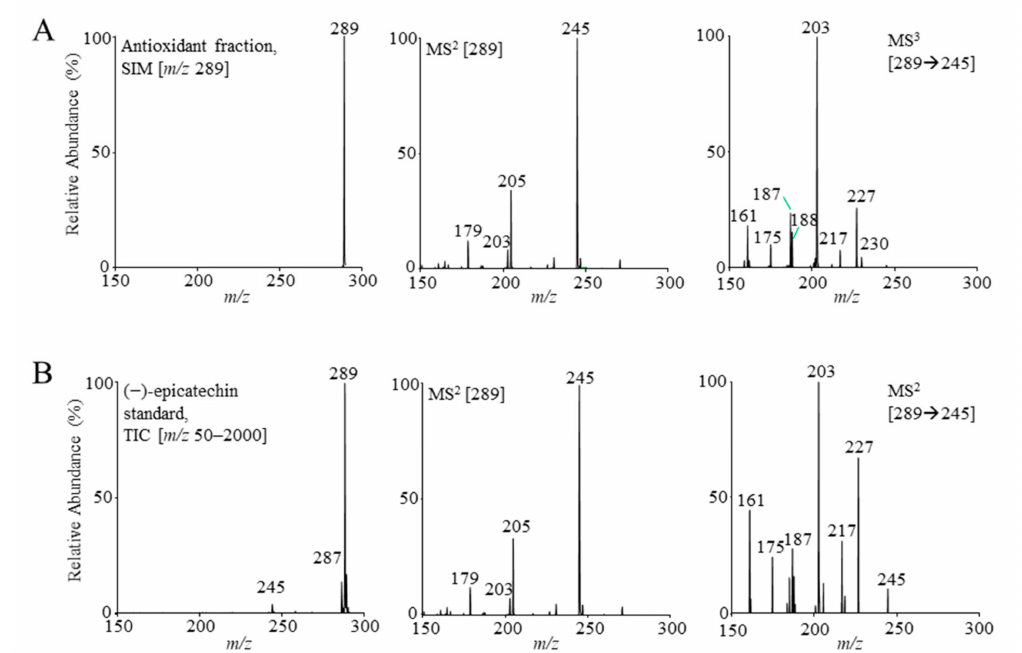
Figure 5. The flavan-3-ol monomer identified by ( − )ESI-MS based on the mass spectra and fragmentation patterns obtained for the signal at t R 6.4 min in the antioxidant fraction (FR 8) ( A ) and confirmed by ( − )-epicatechin standard ( B ). Figure abbreviations: selected ion monitoring (SIM), and total ion current (TIC).